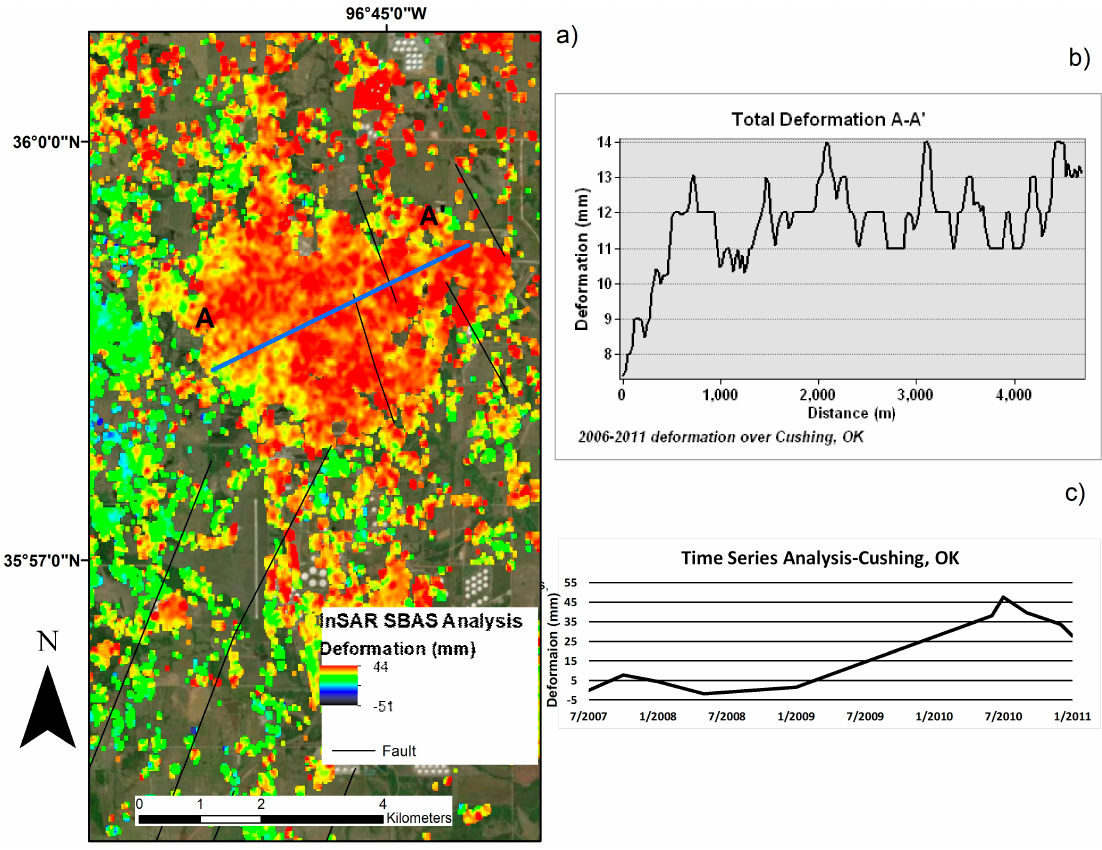
Figure 7. Area of Interest One-Cushing, Oklahoma: ( a ) Results of InSAR analysis showing total deformation for the timeframe of 2006–2011; ( b ) Horizontal depiction of total deformation along profile line A-A’; ( c ) Time series analysis for city of Cushing, Oklahoma. All deformation is measured in LOS. Negative values represent movement away from the satellite, whereas positive values indicate movement towards the satellite.